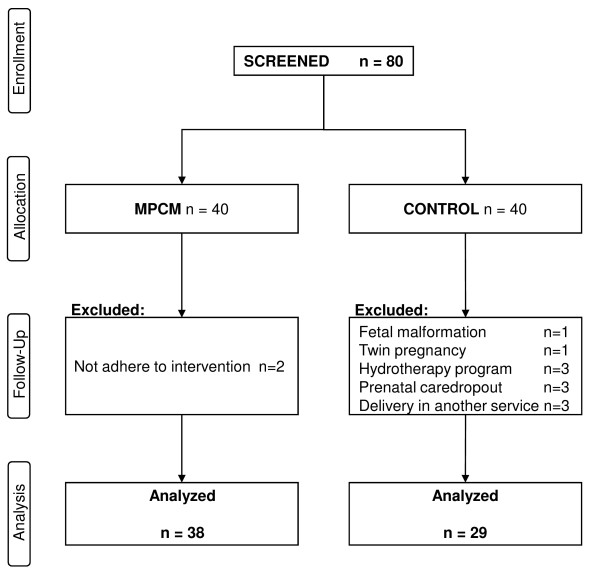
Flow chart of the subjects through the phases of the study.